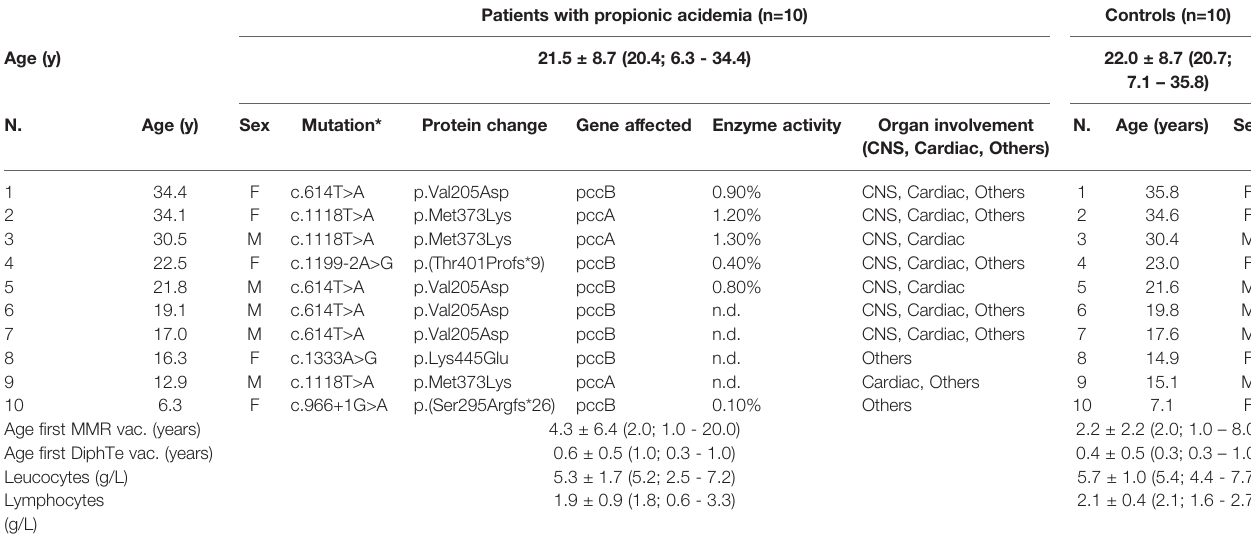
TABLE 1 | Demographic data and characteristics of patients and controls.